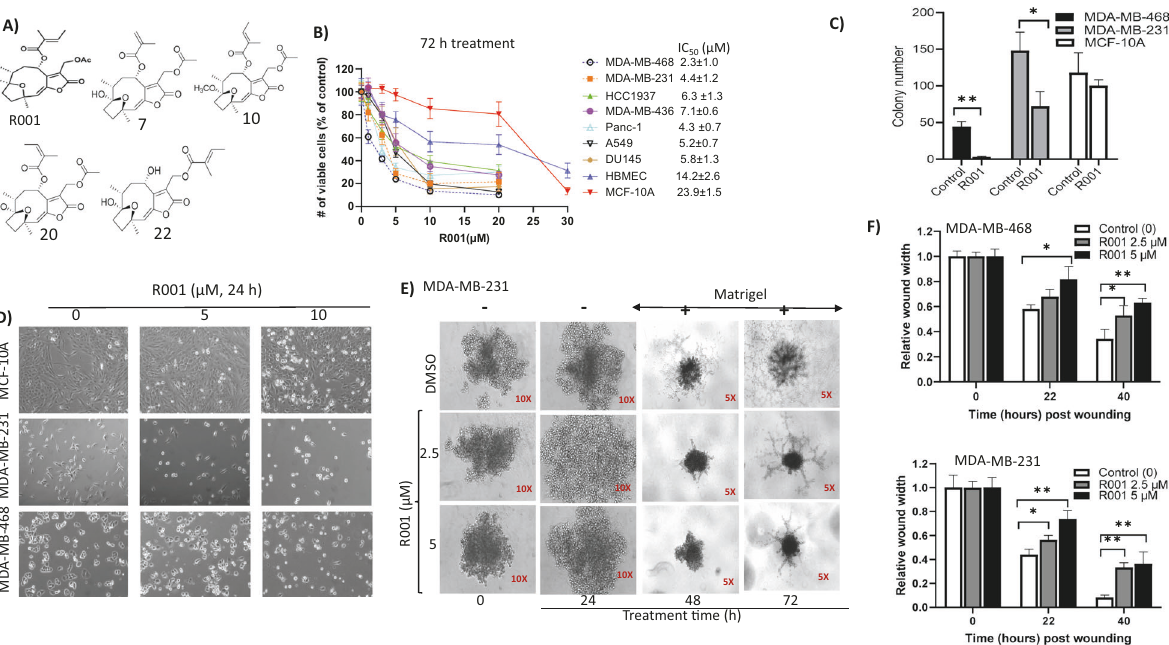
Fig. 1 R001 inhibits viable cell numbers, anchorage-dependent and independent growth, and migration and alters the morphology of triple-negative breast cancer cells. A Chemical structures of R001, compounds 7, 10, 20, and 22; B effects of R001 on the viable cell numbers of the indicated cell lines growing in culture, treated with 0 – 30 µM R001 for 72 h and subjected to CyQuant cell proliferation assay. Insert IC 50 values; n = 6; C single-cell cultures of MDA-MB-468, MDA-MB-231, and MCF-10A cells treated once with 0 – 1 μ M R001 and allowed to grow until large colonies were visible, which were stained with crystal violet, counted and plotted; n = 3; D phase-contrast microscopic images of the indicated cells growing in culture and untreated or treated with 0 – 10 µM R001 for 24 h; E images taken at 5X and 10X magni fi cations of MDA-MB-231 cells growing as 3D spheroids formed over a 48-h duration, which were untreated (DMSO) or treated once with 2.5 or 5 μ M R001 for 24 h prior to ( − ) the addition of matrigel ( + ), and allowed to grow for up to 72 h post treatment and imaged at 24 h intervals; and F cultured MDA-MB-468 and MDA-MB-231 cells, which were wounded, treated once with 0 – 5 µM R001 and allowed to migrate to the denuded area over 22 – 40 h; n = 3. The relative wound width was measured and plotted against treatment time. Control lane (0, – ) represents cells treated with 0.1% DMSO. Values, mean ± SD. Data are representative of 2 – 3 independent determinations. * P < 0.05 and ** P <